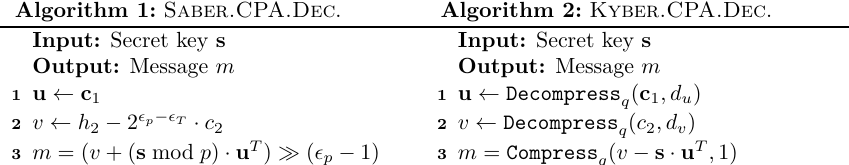
Algorithm 1: Saber.CPA.Dec .